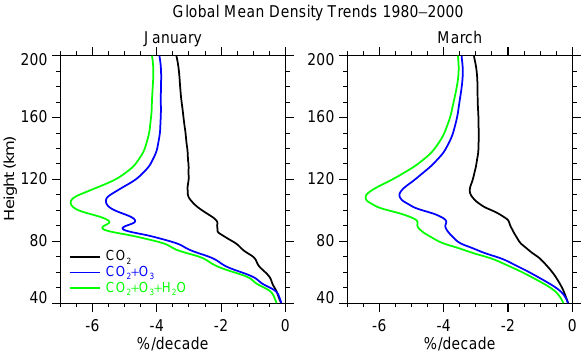
Fig. 1. Simulated global mean density trends for the period 1980– 2000 at solstice (left) and equinox (right): CO 2 forcing alone (black); combined CO 2 and O 3 forcing (blue); and combined CO 2 , O 3 , and H 2 O forcing (green) (Akmaev et al.,